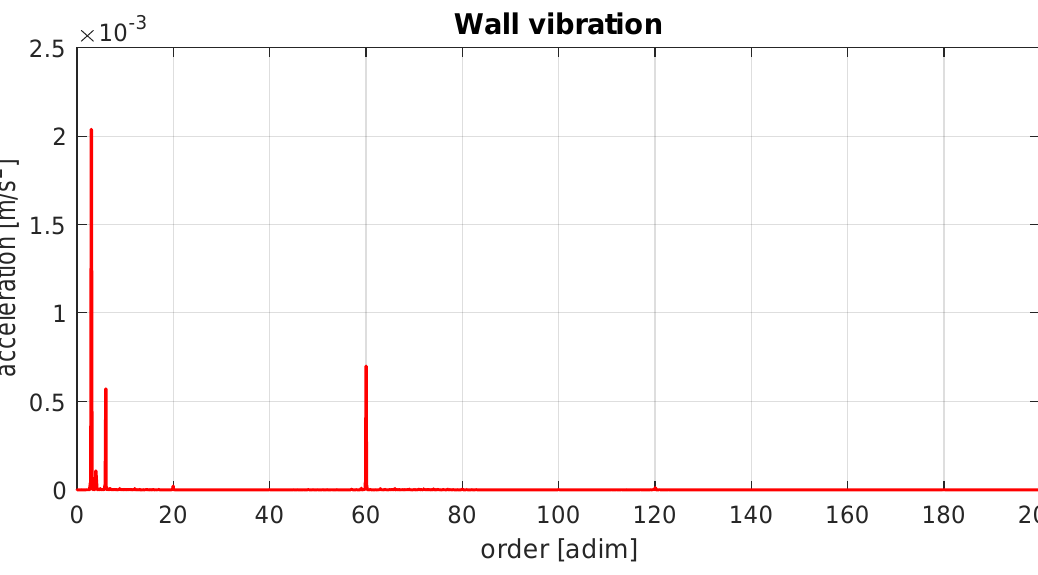
Figure 13. Order spectra of wall